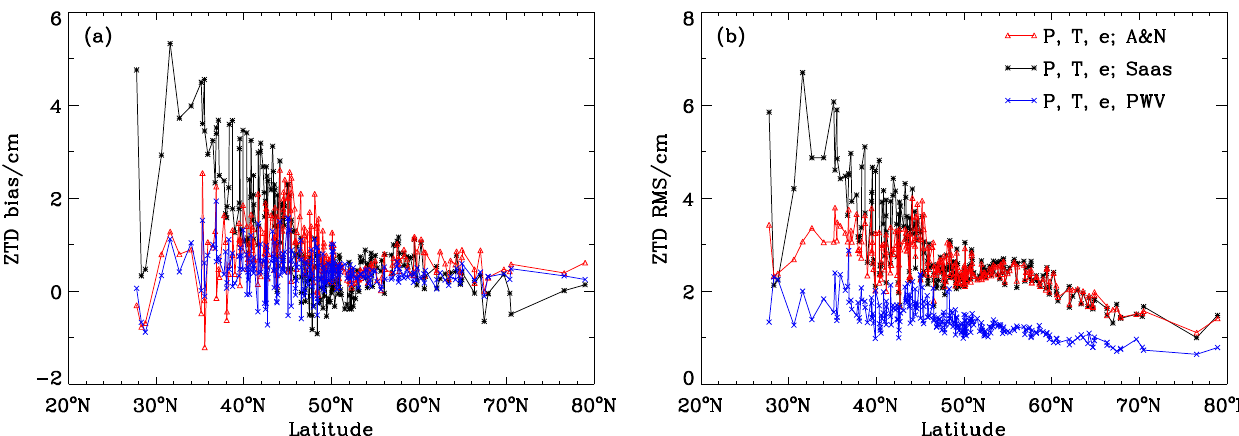
Figure 10. Bias ( a ) and RMS ( b ) values of the differences between GNSS-ZTDs and ZTDs derived from ERA surface analysis data (2.5° × 2.5°) over 302 EPN stations in Europe during 2015. The red line and black line indicate results of ZTDs obtained from derived P , T , and e with the A&N model and the Saas model respectively, while the blue line indicates results of ZTDs obtained from derived P , T , e , and